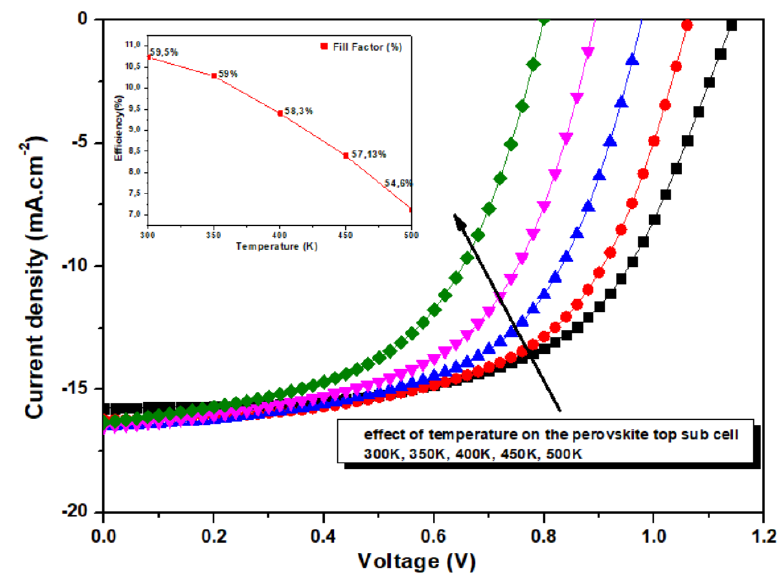
Figure 16. Effect of the working temperature on the J–V curve of the perovskite top sub-cell.